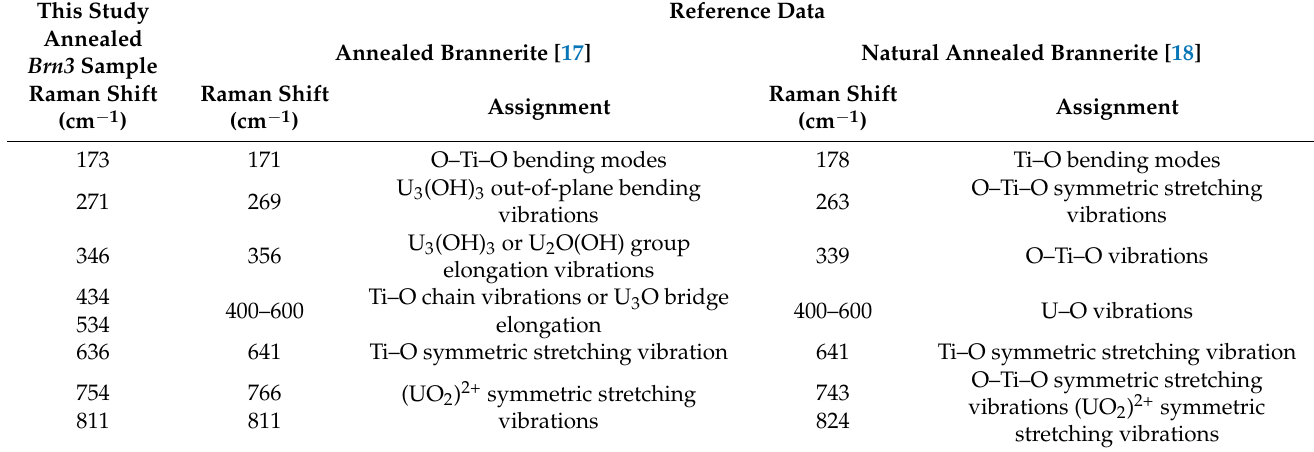
Table 3. Raman bands and their assignment in the annealed studied brannerite sample and the ref- erence data from [18,19].